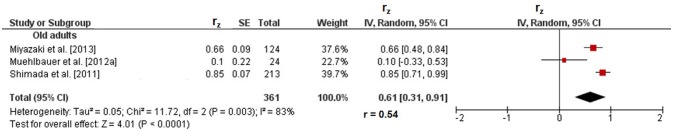
Pearson's r-values (z-transformed) for correlations between dynamic steady-state and proactive balance in old adults. CI confidence interval, df degrees of freedom, r back-transformed Pearson's correlation coefficients, rz weighted z-transformed Pearson's correlation coefficients, SE standard error, IV inverse variance.